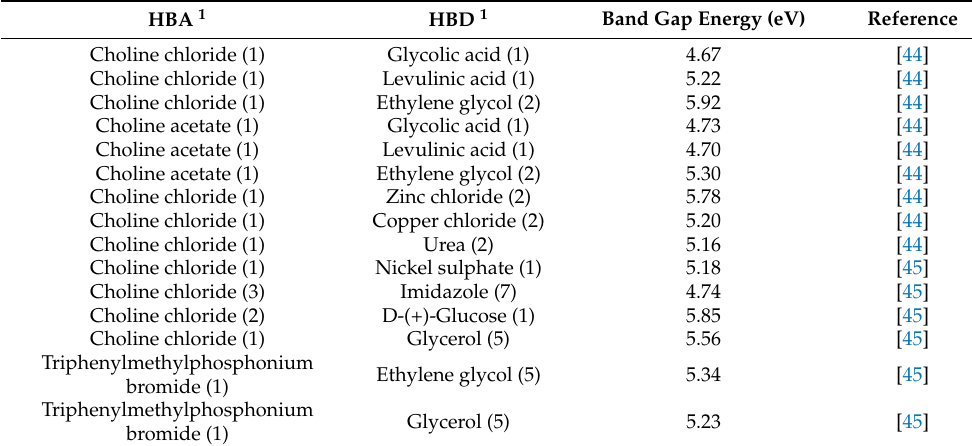
Table 2. Band gap energies of some binary DESs.